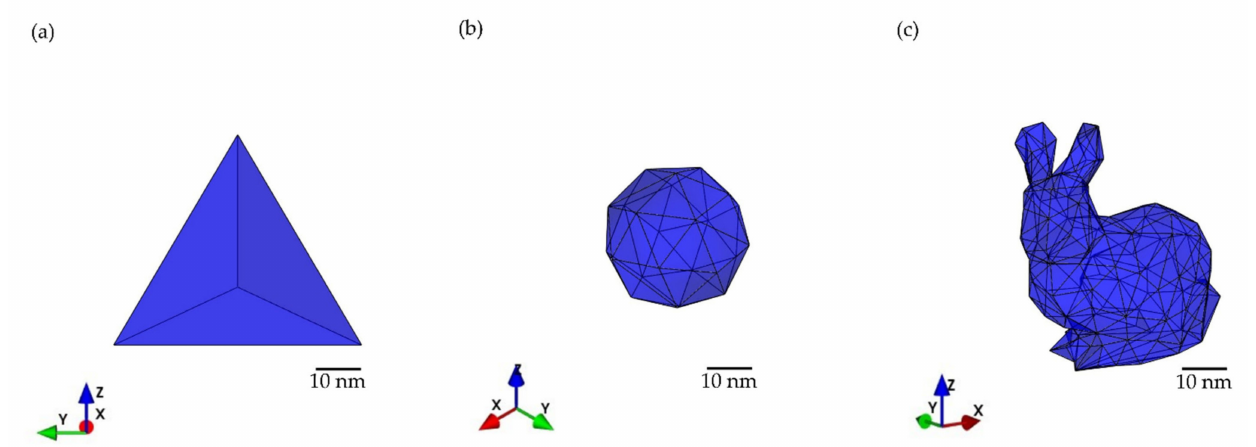
Figure 5. Input triangular mesh with a scale bar of 10 nm in length: ( a ) Tetrahedron mesh with dimensions for the filling application of the axis aligned bounding box of 47.6 nm in length, 55.0 nm in width, and 45.9 nm in height. This mesh has a volume of 19,600 nm 3 ; ( b ) Snub cuboctahedron mesh with the axis aligned bounding box of 35.1 nm in length, 36.0 nm in width, and 35.8 nm in height. This mesh has a volume of 20,000 nm 3 ; ( c ) Stanford bunny mesh with the axis aligned bounding box of 54.1 nm in length, 43.3 nm in width, and 53.6 nm in height. This mesh has a volume of 34,200 nm 3